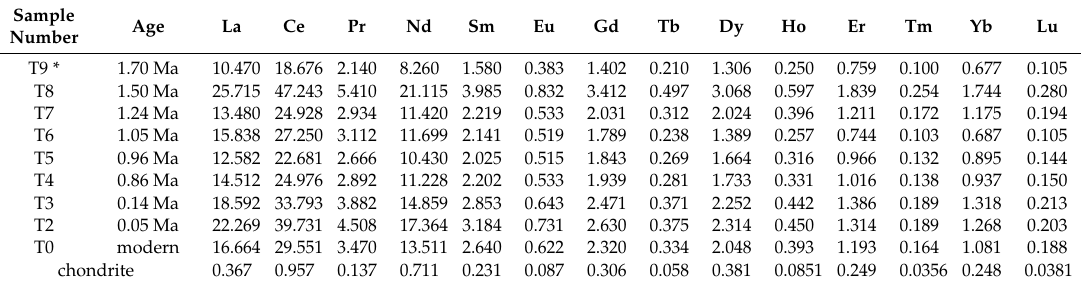
Figure 4. Chondrite-normalized REE patterns for Yellow River terraces of the Lanzhou area. Table 2. Rare earth elements concentrations (ppm) in sediments from the Yellow River terraces in the Lanzhou area